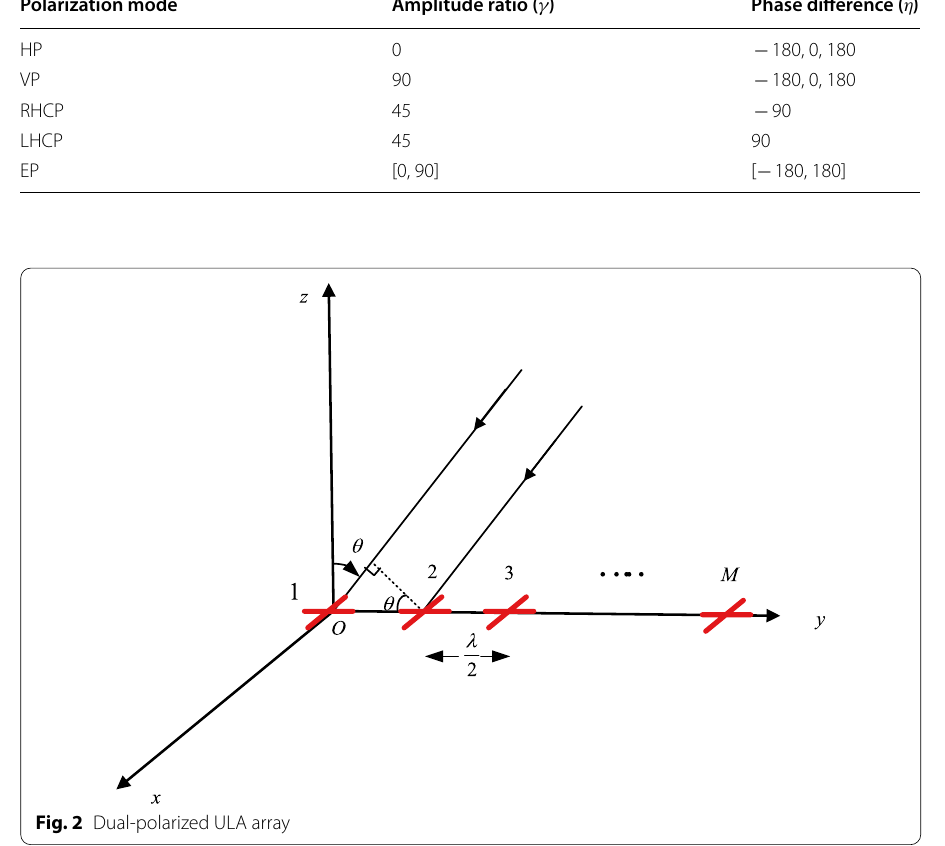
Fig. 2 Dual-polarized ULA